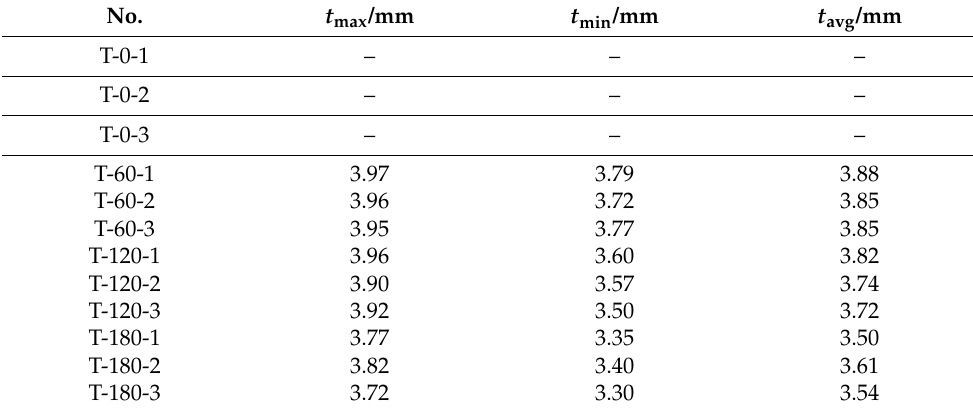
Table 3. The residual thickness of tensile samples.